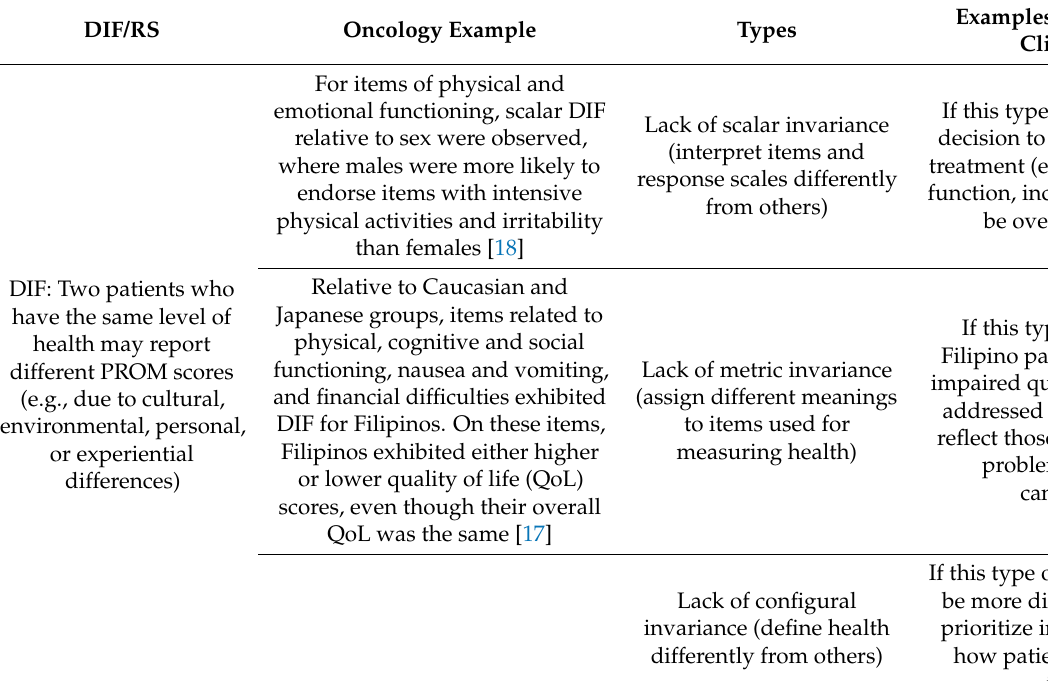
Table 1. Implications of different types of differential item functioning and response